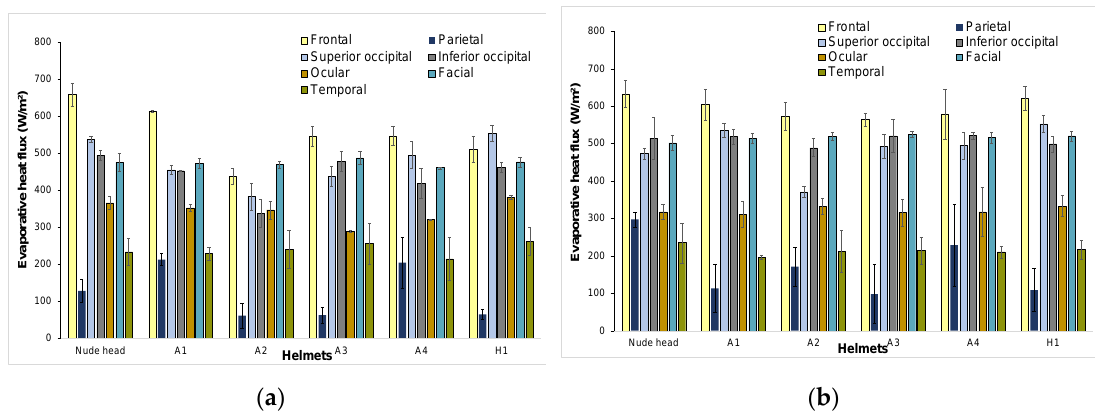
Figure 8. Zonal apparent evaporative heat-flux distribution at ( a ) 3 m/s; ( b ) 6 m/s.